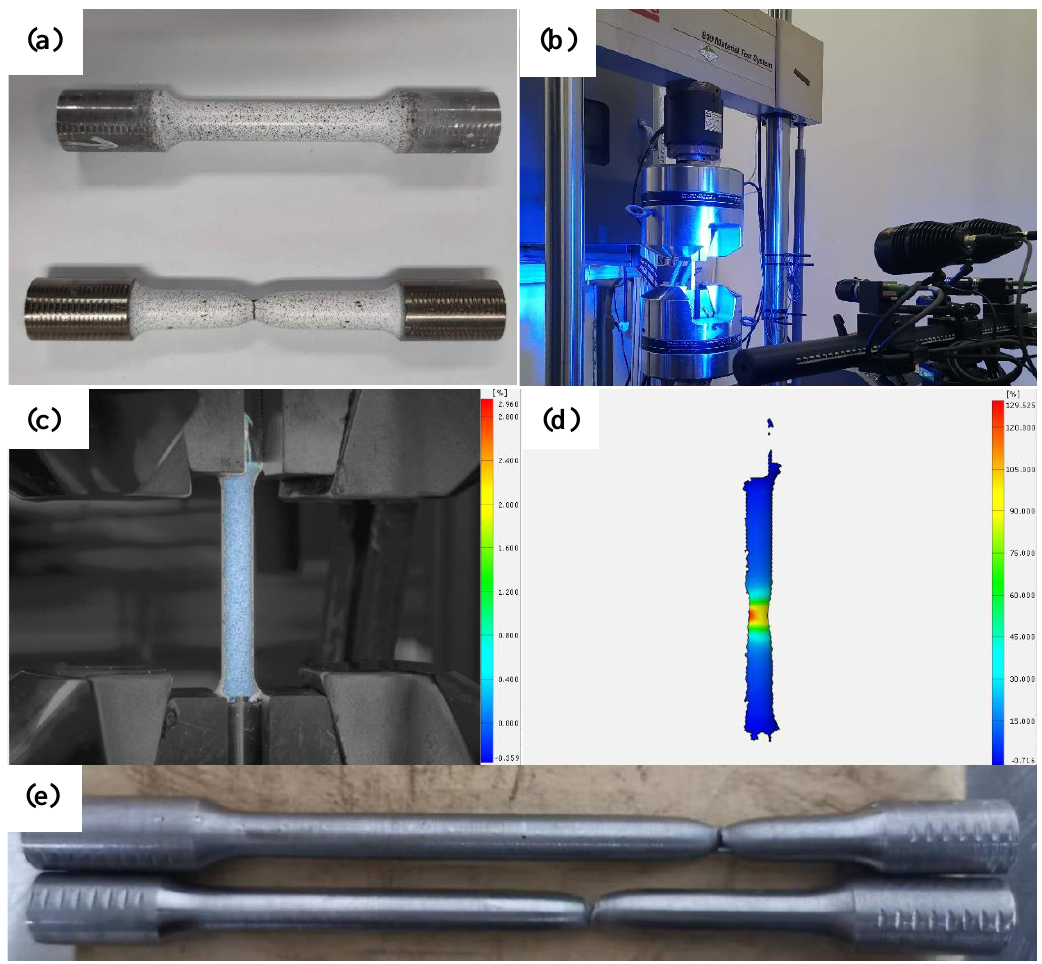
Figure 2. Tensile tests of pipe metal and all-weld-metal for the high-strain marine pipe. ( a ) The specimens of tensile test by DIC; ( b ) Tensile test of pipe metal by DIC; ( c ) Speckle area on the specimen of pipe metal; ( d ) Speckle analysis; ( e ) Tensile specimens of all-weld-metal.